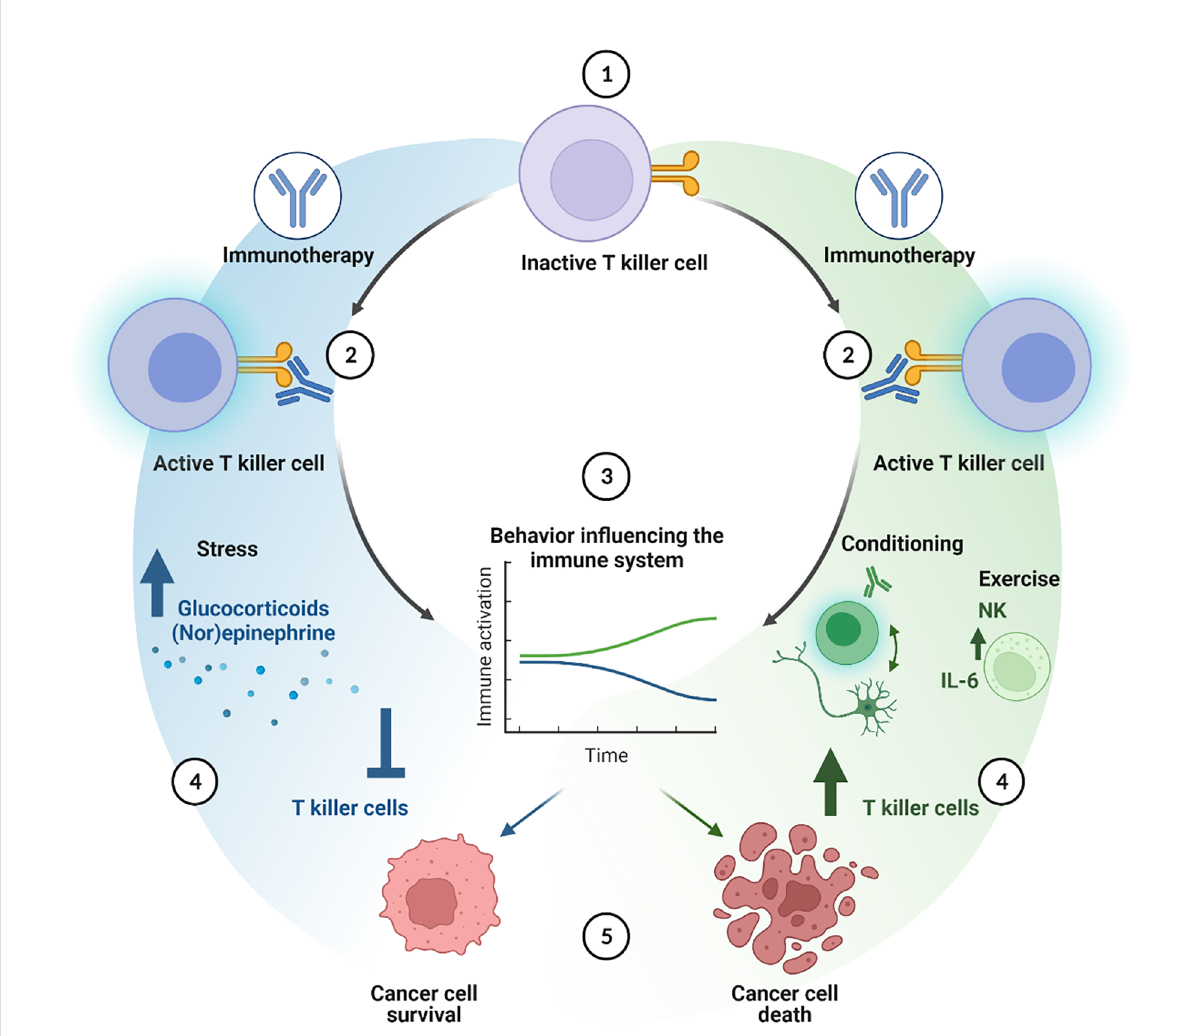
FIGURE 3 Cellular cascade of additive effects of behavioral interventions on immune checkpoint inhibition therapy. Immune checkpoint inhibition activates T killer cells (1 and 2). Behavioral factors or interventions can either improve (green line) or decrease (blue line) the effects of the immune therapy (3). Stress hampers the immune system through for instance the effects of glucocorticoids and (nor)epinephrine, inhibiting T killer cell function and numbers, thereby enhancing cancer cell survival (4 and 5, blue cascade). Classical pharmacological conditioning can enhance T killer cell activity and numbers mediated by brain-immune communication. Exercise may increase the amount of NK cells, induce IL-6 secretion, altogether improving T killer cell activation, leading to a better anti-tumor response (4 and 5, green cascade) created with